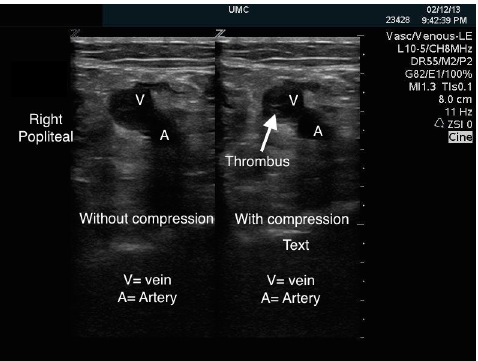
Figure 1. Dual image demonstrating right lower extremity popliteal vein clot with and without compression. The popliteal vein does not compress demonstrating active popliteal deep vein thrombosis.